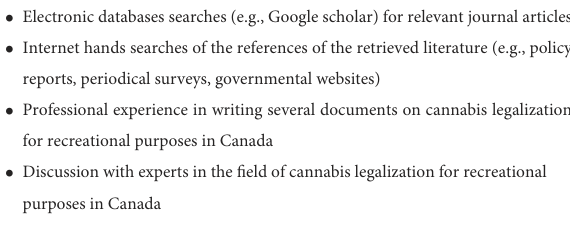
TABLE 1 Information sources used for this narrative